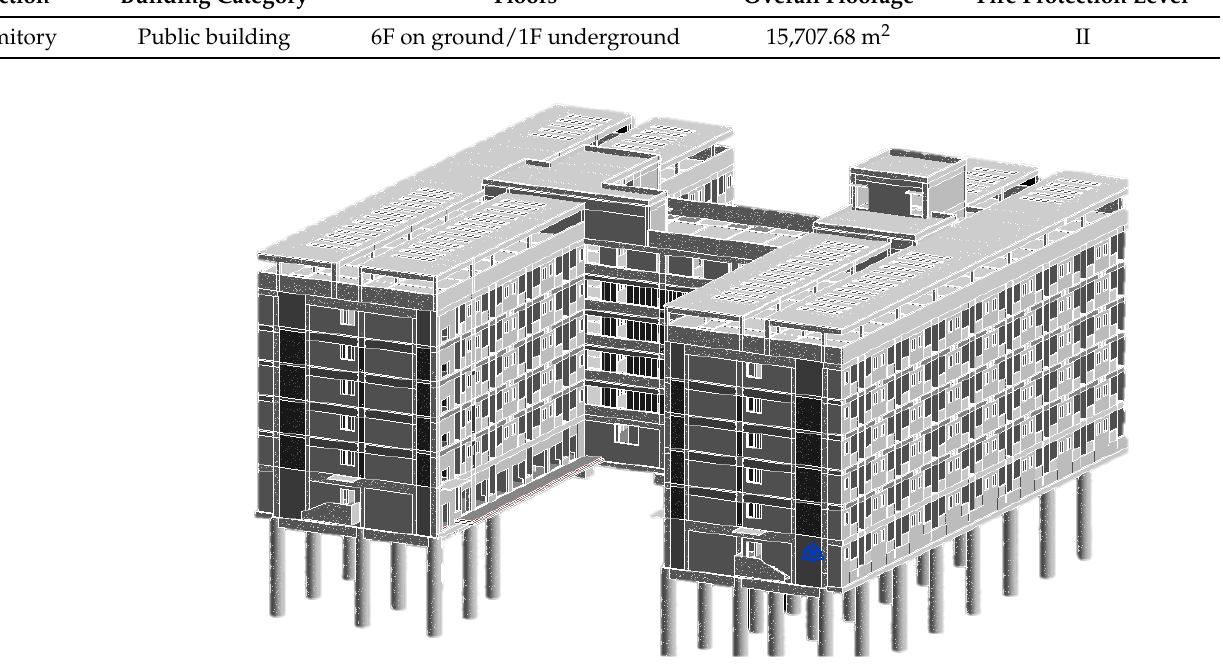
Figure 3. The BIM Model of the Case